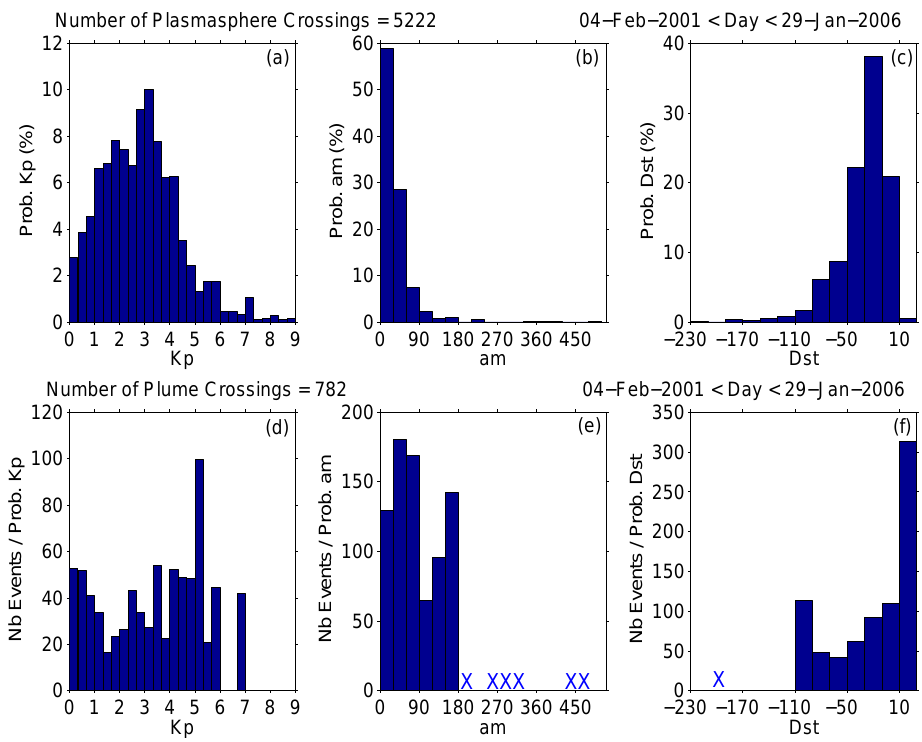
Fig. 9. Occurrence of plasmasphere passes (top panels) and plasmaspheric plumes (bottom panels) as a function of the indices K p , am and D st during the five years of Cluster data analysed. (a) Distribution of the K p values for the plasmasphere passes. (b) Distribution of the am values for the plasmasphere passes. (c) Distribution of the D st values for the plasmasphere passes. (d) K p distribution of the plumes, weighted by the K p occurrence probability. (e) am distribution of the plumes, weighted by the am occurrence probability. (f) D st distribution of the plumes, weighted by the D st occurrence probability. A blue cross means that there are no plasmasphere passes with such